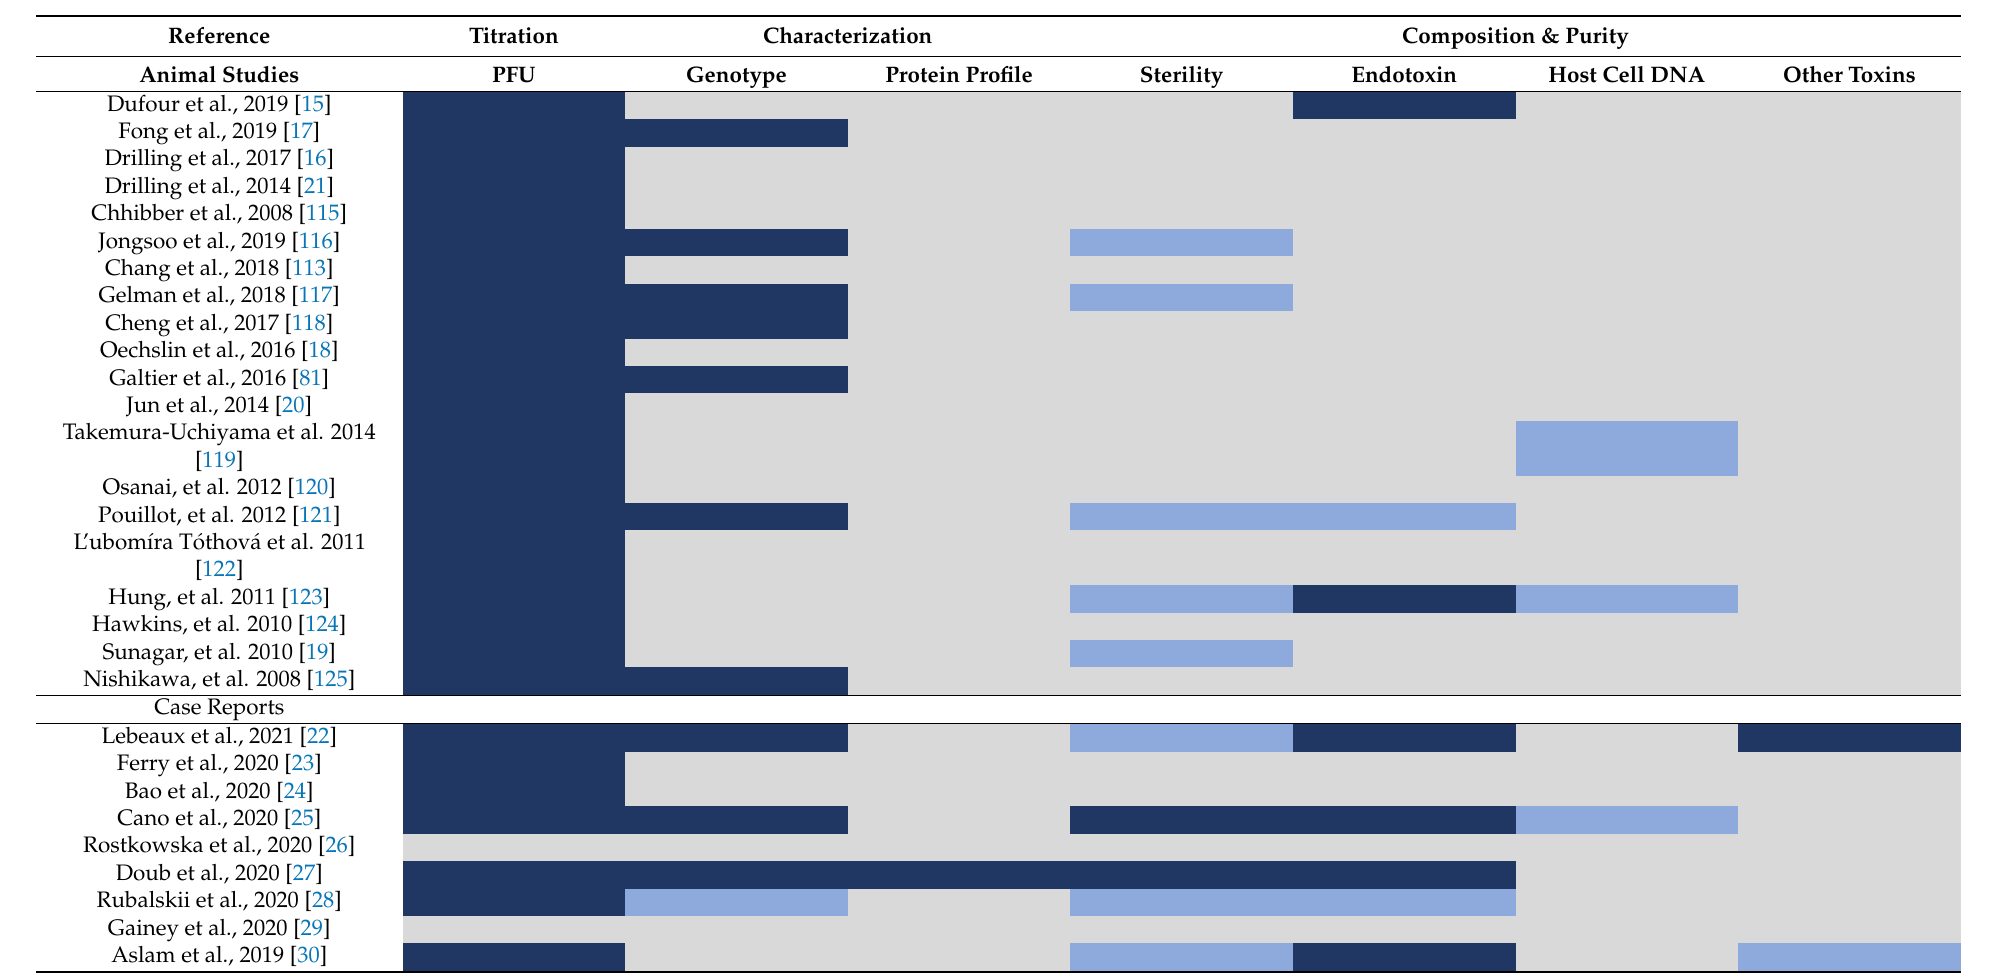
Table 2. Characteristics of phage preparations used in the phage therapy